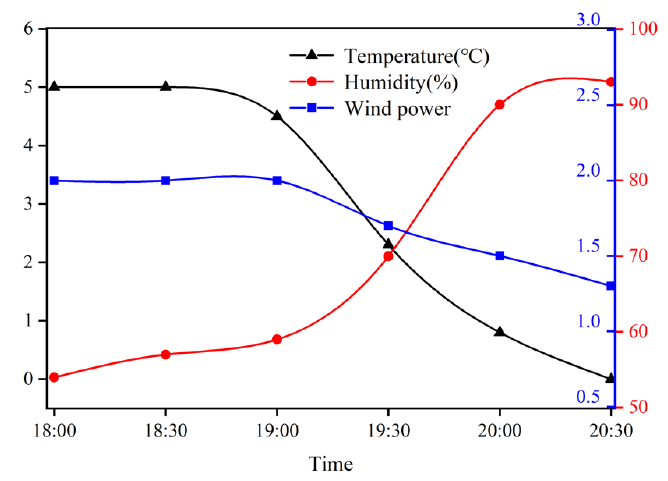
Figure 3. The environmental conditions during the navigation monitoring.